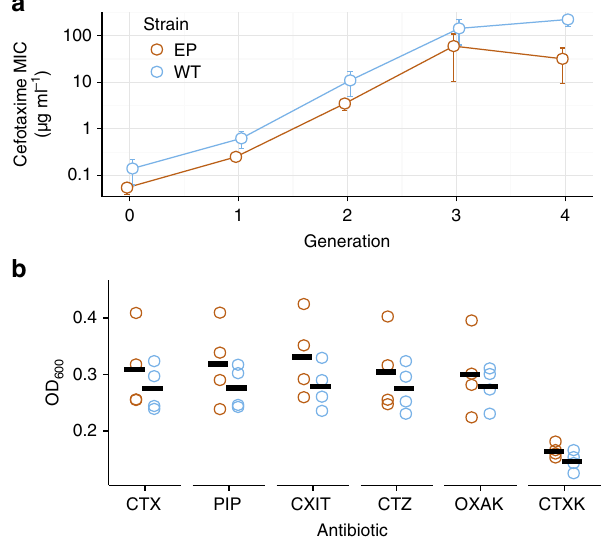
Figure 2 | Antibiotic resistance after evolution. ( a ) Mean increase in the MIC of cefotaxime for each of the two hosts during four rounds of evolution on cefotaxime. Circles correspond to means and error bars represent 1 s.d. across four replicate populations. ( b ) Population densities of TEM-1 variants (red ¼ evolved in error-prone hosts; blue ¼ evolved in wild-type hosts) after the fourth round of evolution and after 24h of growth in wild-type hosts on various b -lactam antibiotics (CTX ¼ 0.25 m gml (cid:2) 1 cefotaxime, PIP ¼ 8 m gml (cid:2) 1 piperacillin, CXIT ¼ 0.0625 m gml (cid:2) 1